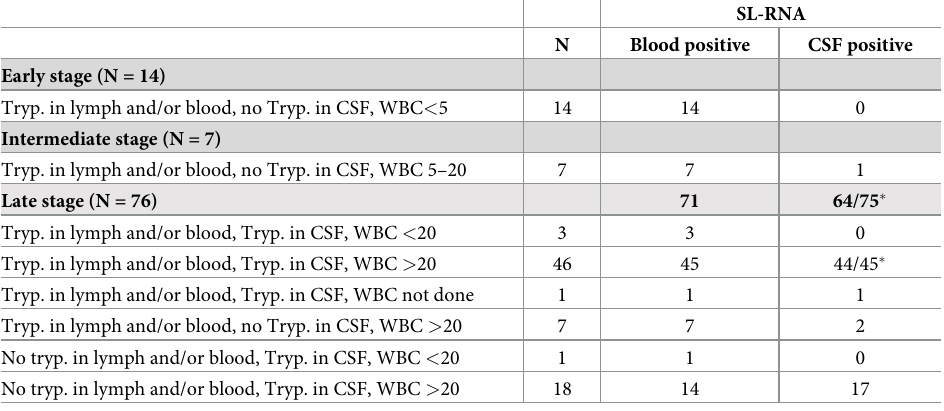
CSF specimen missing for 1 patient; WBC = CSF white blood cell count/ μ